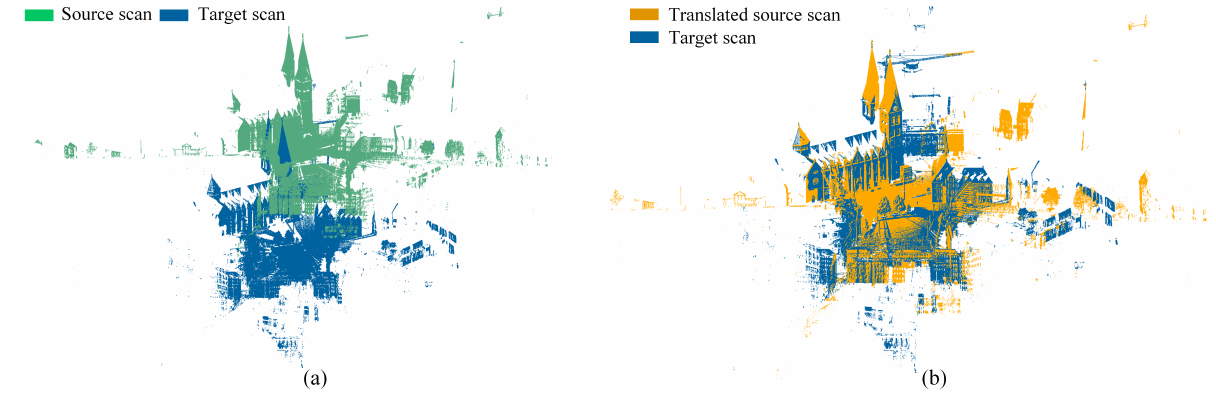
Figure 3. Data and results of Bremen dataset. (a) Source and target point clouds. (b) Matching result.